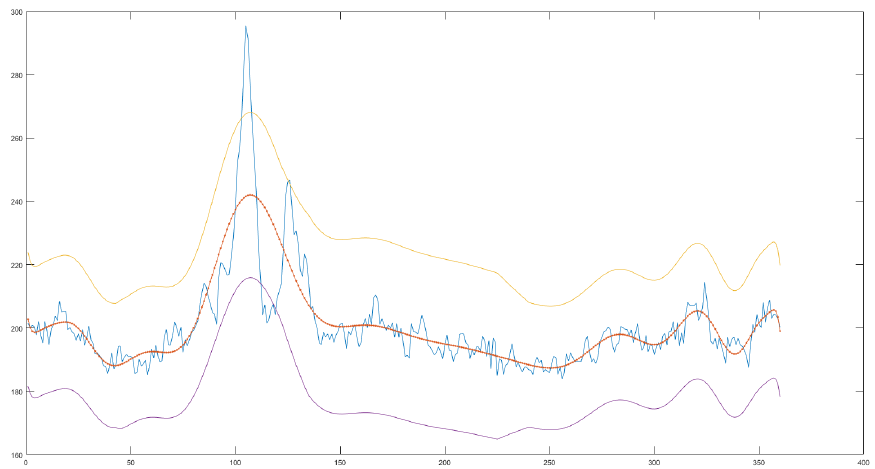
Figure 12. Results of the Chebyshev polynomial fitting applied to the histogram in Figure 11. The fit order n has been set empirically to 30.